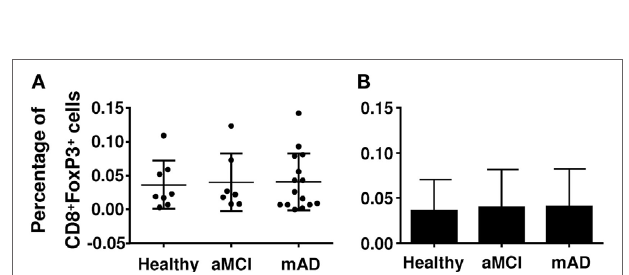
FigUre 3 | Expression of CCR4 and CD28 on regulatory T cells (Tregs) of healthy, amnestic mild cognitive impairment (aMCI), and mild AD (mAD) subjects. (a) CCR4 number in Tregs defined by the CD4 + FoxP3 + marker in individual participants. (B) Corresponding histograms. (c) CD28 number in Tregs defined by the CD4 + Foxp3 + CD25 high marker in individual participants. (D) Corresponding histograms. Each group was composed of at least five independent subjects with determinations made in triplicate. Data are shown as the mean ± SEM.